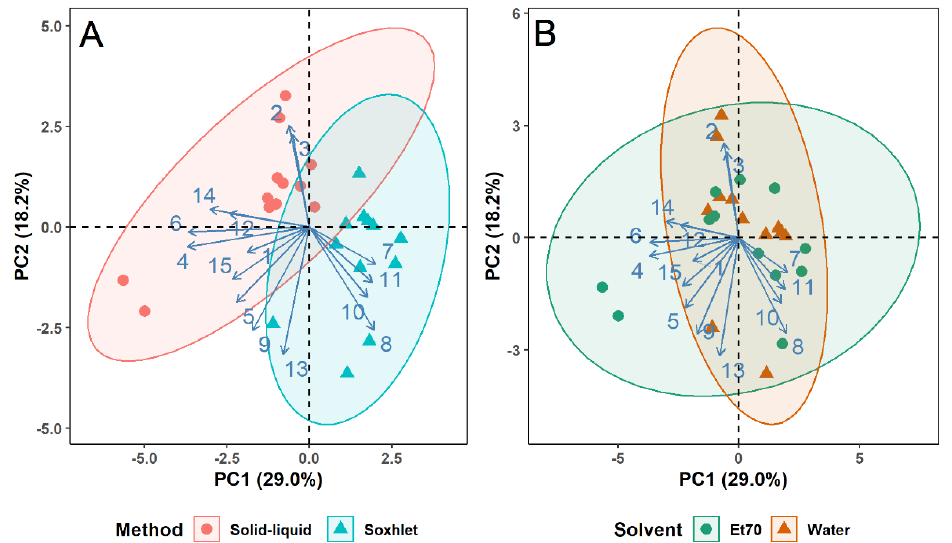
Figure 6. Score plots of the first two components of the principal component analysis (PCA) of phenolic compounds grouped by extraction method ( A ) and solvent ( B ). Phenolic compounds: 1– Chlorogenic acid, 2-Vanillic acid, 3-Syringic acid, 4-Cinnamic acid, 5- p -coumaric acid + epicate- chin, 6- o -coumaric acid, 7-Rosmarinic acid, 8-Ellagic acid, 9–Naringin, 10–Hesperidin,